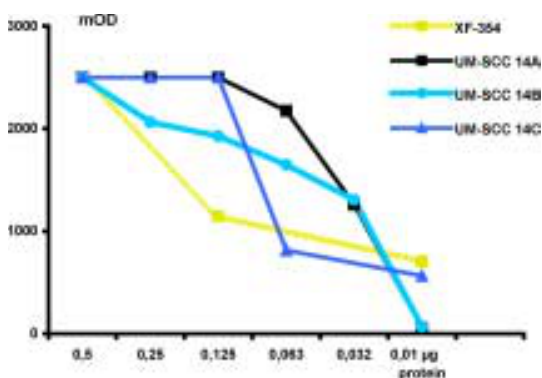
Fig. 1. Telomerase activity in the tumour cell lines XF-354 and UM-SCC 14A to 14C. bles, including the calculation of the Chi 2 value und the Fisher Exact Test from the J.C. Pezzullo Webpage (University of Georgetown, USA). All statistical com- parisons are 2-sided.